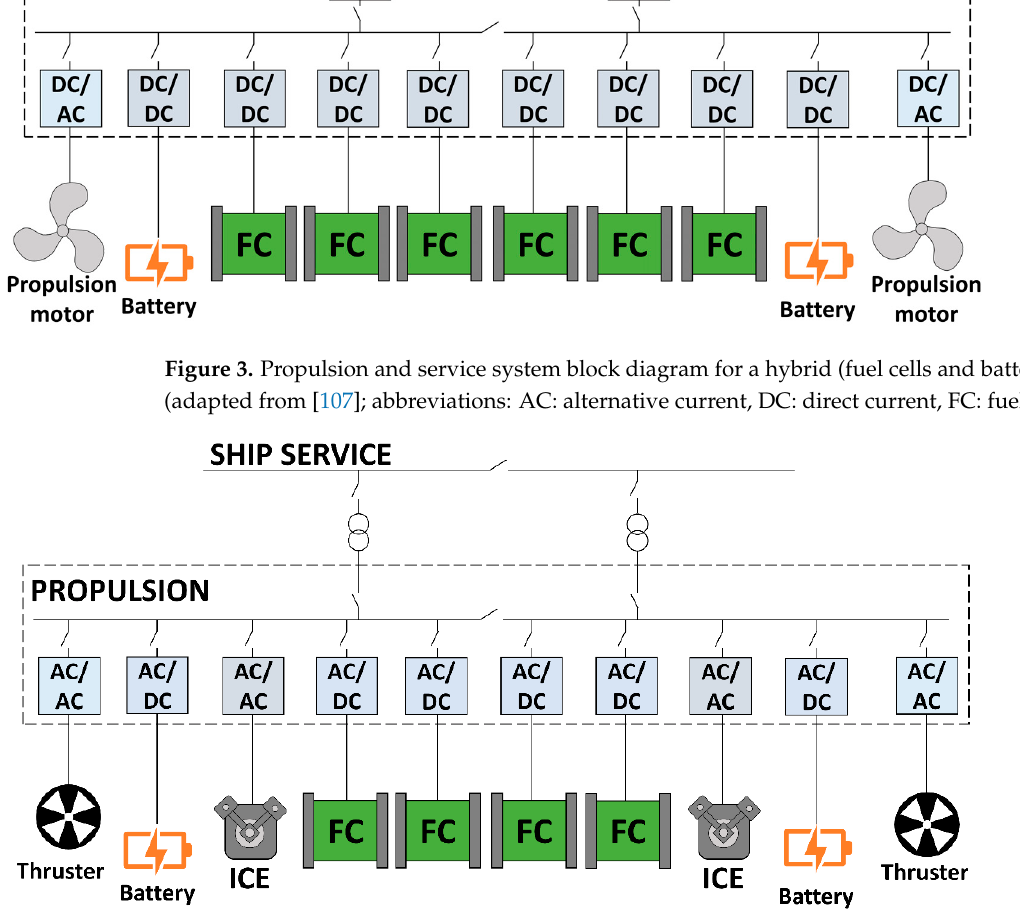
Figure 4. Propulsion and service system block diagram for a hybrid (fuel cells, batteries, and internal combustion engines) system (adapted from [108]; abbreviations: AC: alternative current, DC: direct current, FC: fuel cell, ICE: internal combustion engine).